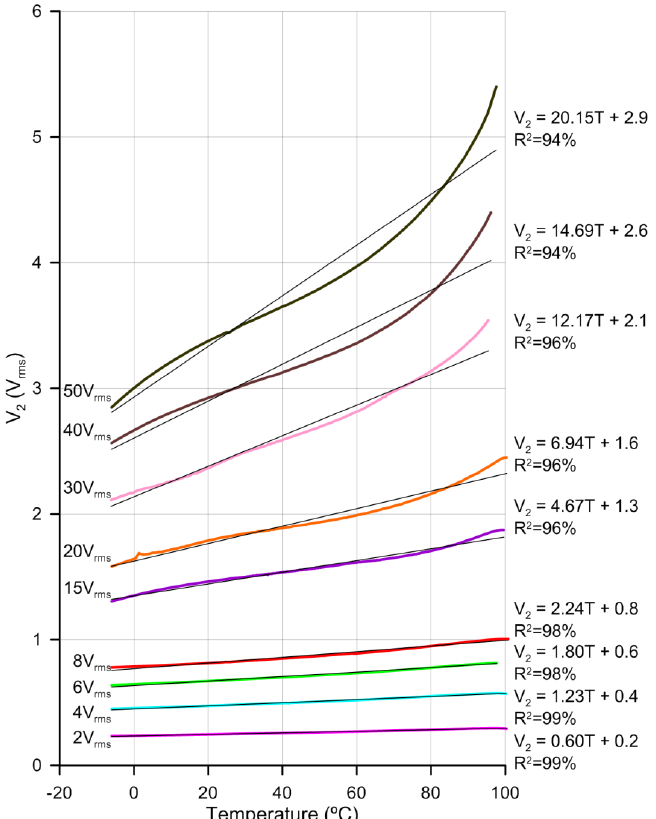
Figure 7. Temperature dependence of the LC sensor response for several voltages at V